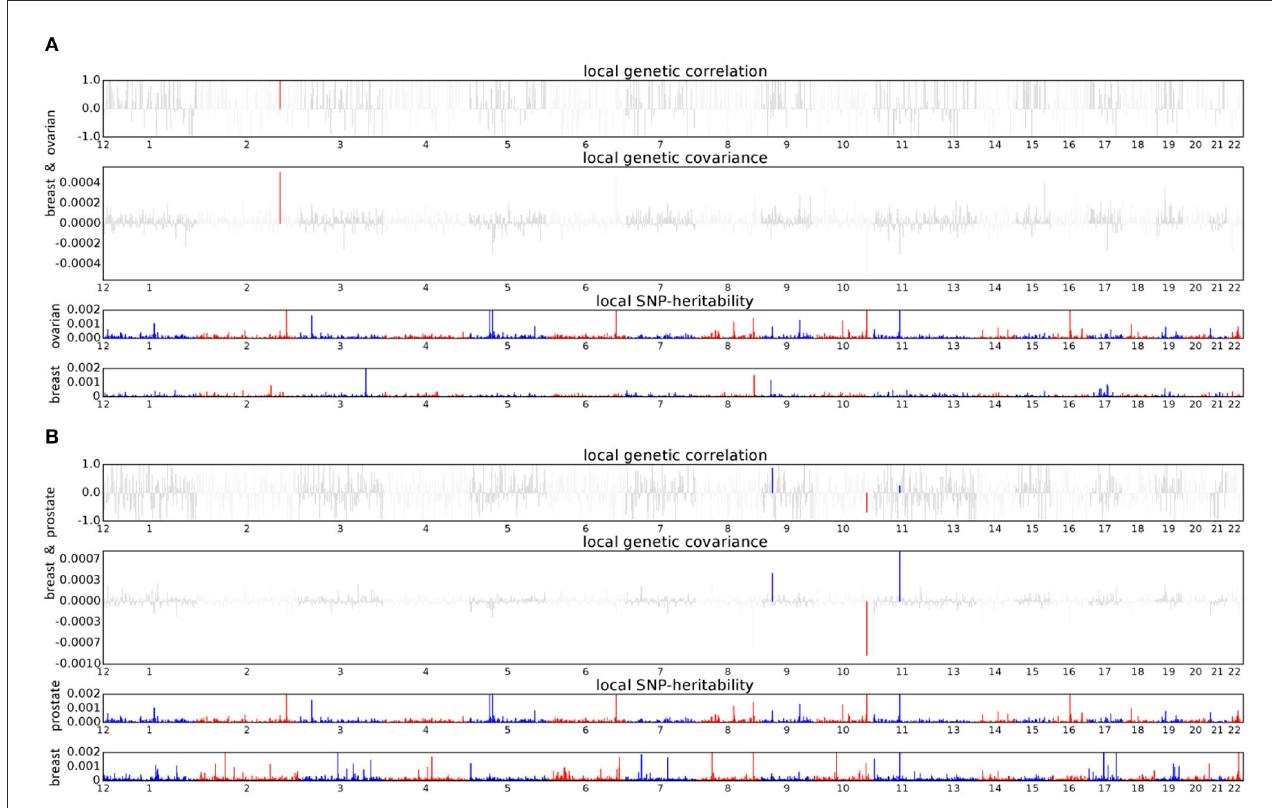
FIGURE3 Local genetic correlation and local SNP heritability between cancer pair. (A) Breast and ovarian cancers; (B) Breast and prostate cancers. For each subfigure, the top part represents local genetic correlation, the middle part represents local genetic covariance, blue or red highlights indicate significant local genetic correlation and covariance after multiple testing corrections, and the bottom part represents local SNP heritability for each